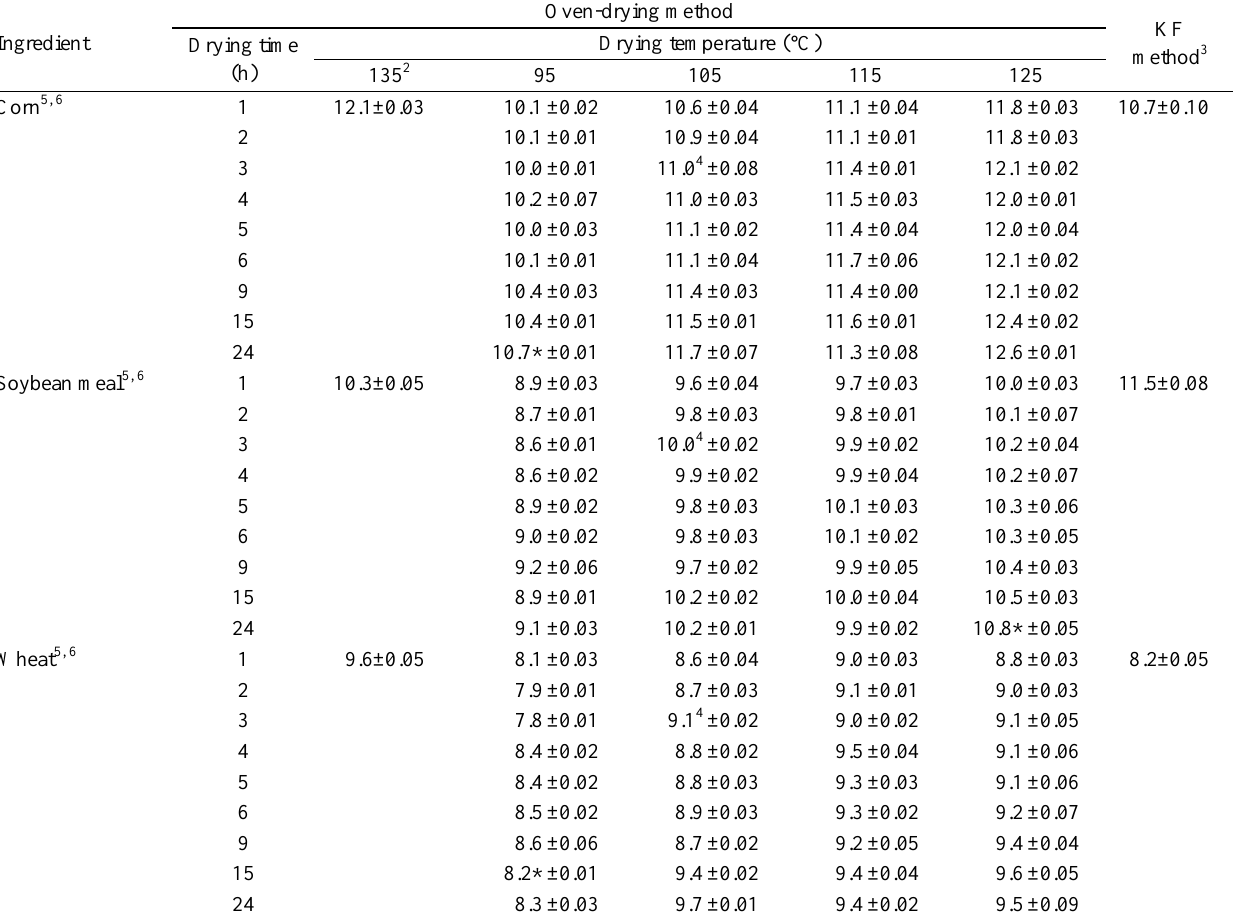
Table 2. Moisture concentrations (%) in corn, soybean meal, and wheat determined by various oven methods and the Karl Fischer (KF) method (Exp. 2)